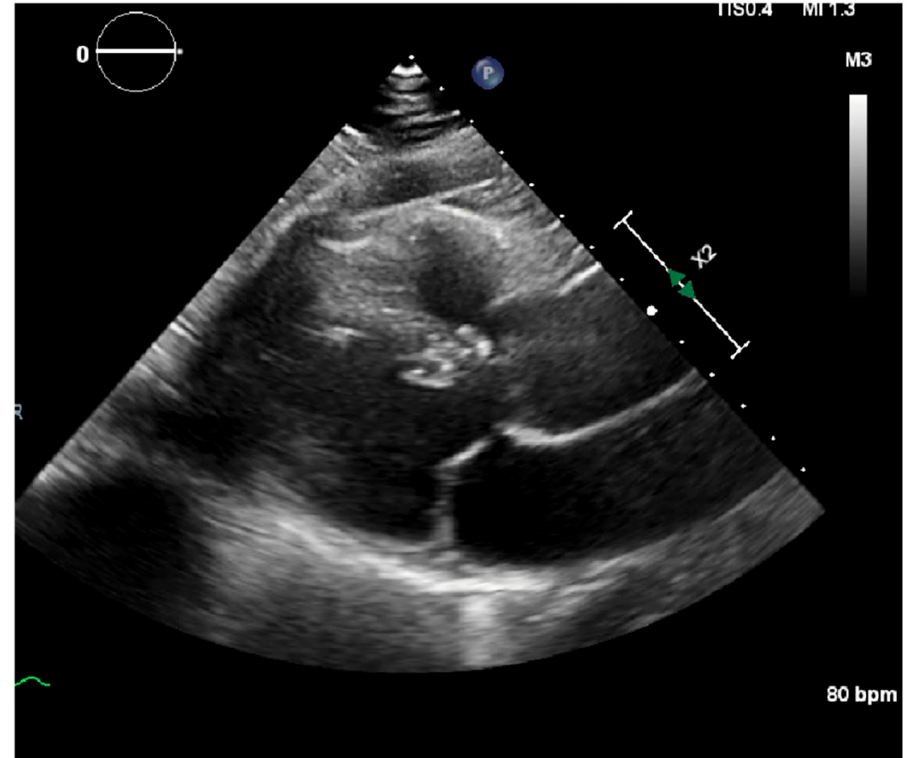
Figure 2. Echocardiography showing mitral valve and left ventricle with no pericardial effusion.